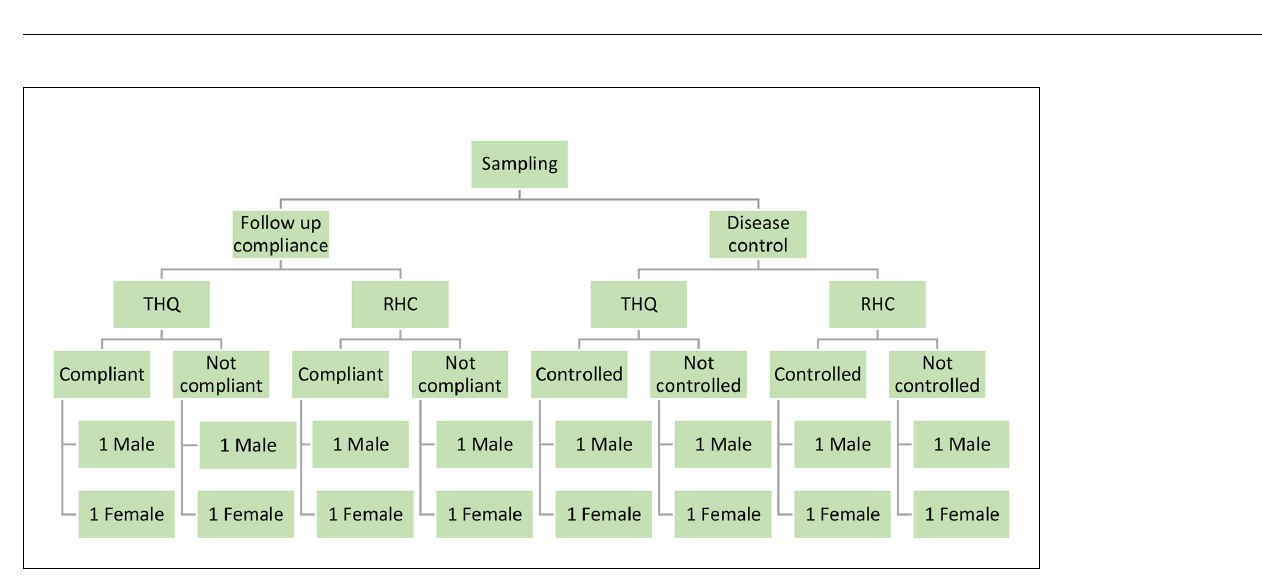
Figure 1 Sampling for interviews. RHC = rural health centre. THQ = Tehsil